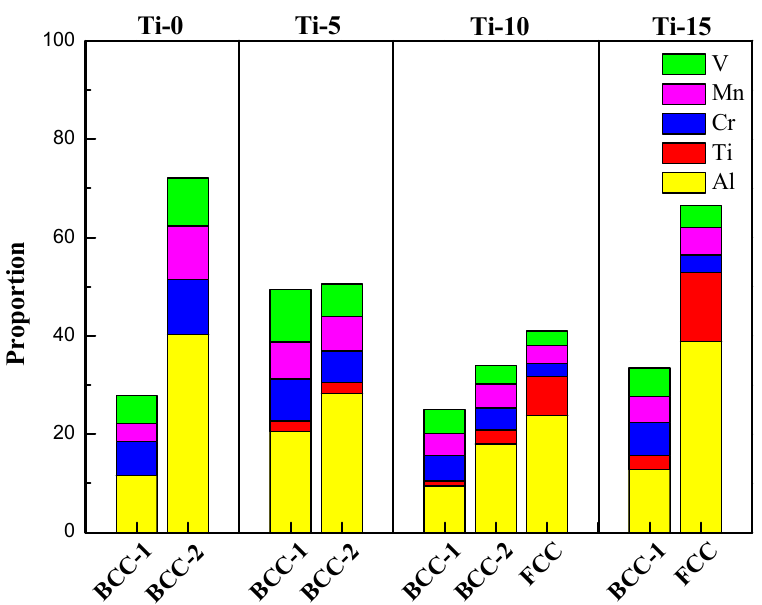
Figure 4. The proportion of Al, Ti, Cr, Mn and V in the dual-phase of Al 50 –Ti–Cr–Mn–V alloys.